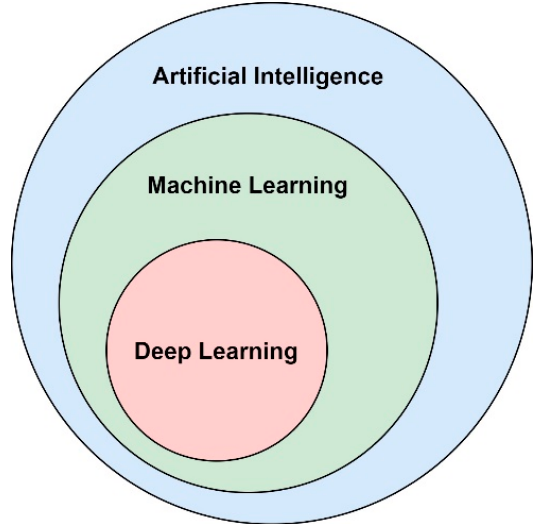
Figure 1. Relationship between AI, ML, and DL.